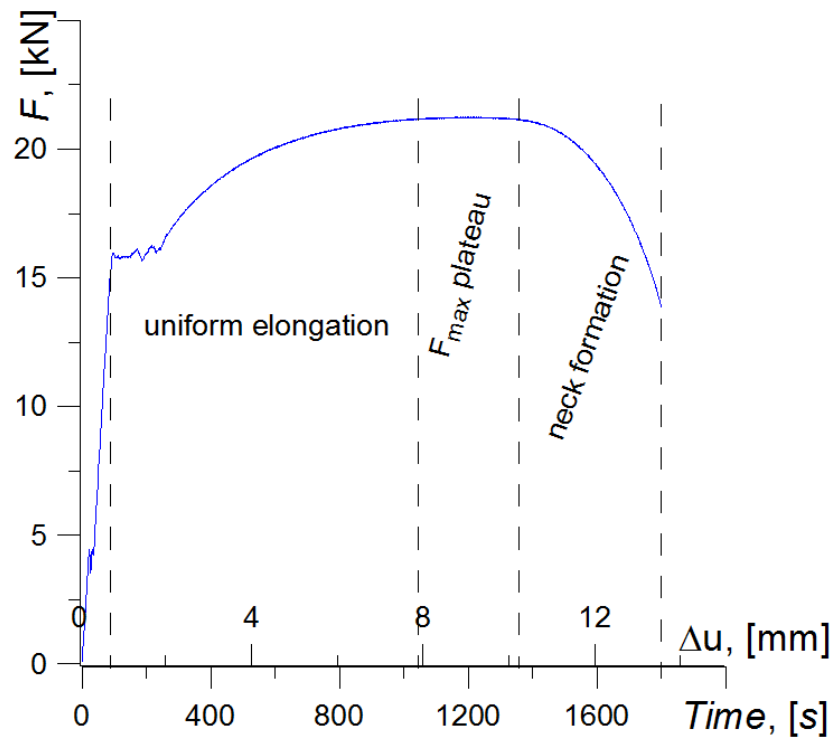
Figure 10. Schematic representation of the intervals of the material failure process during the uniaxial tensile test.